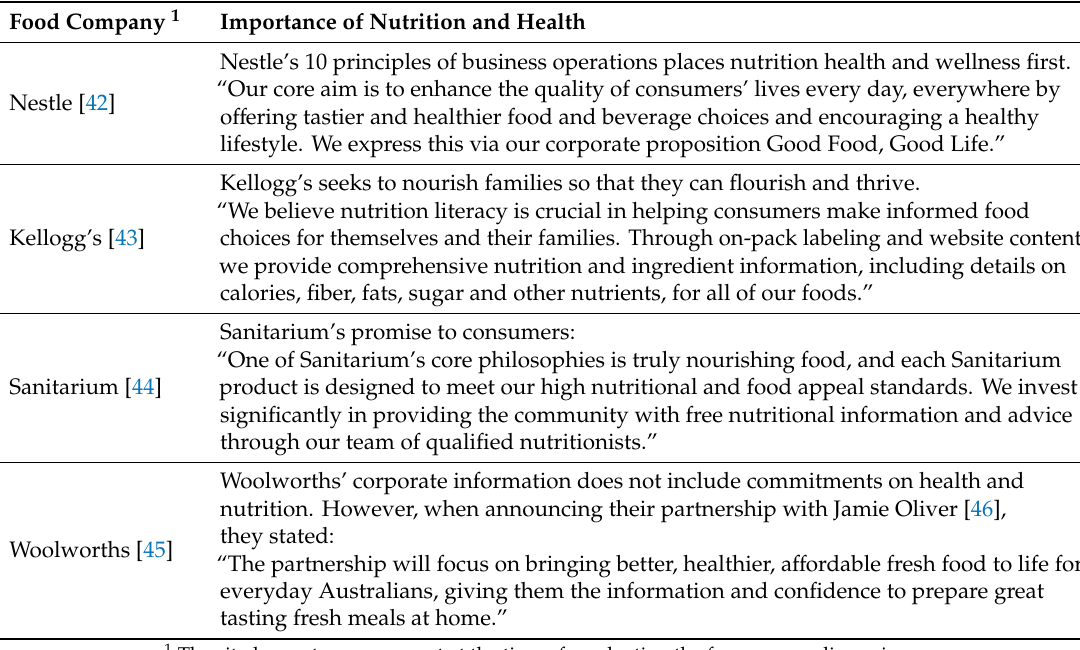
Table 1. Corporate social responsibility commitments of selected high-market-share Australian food